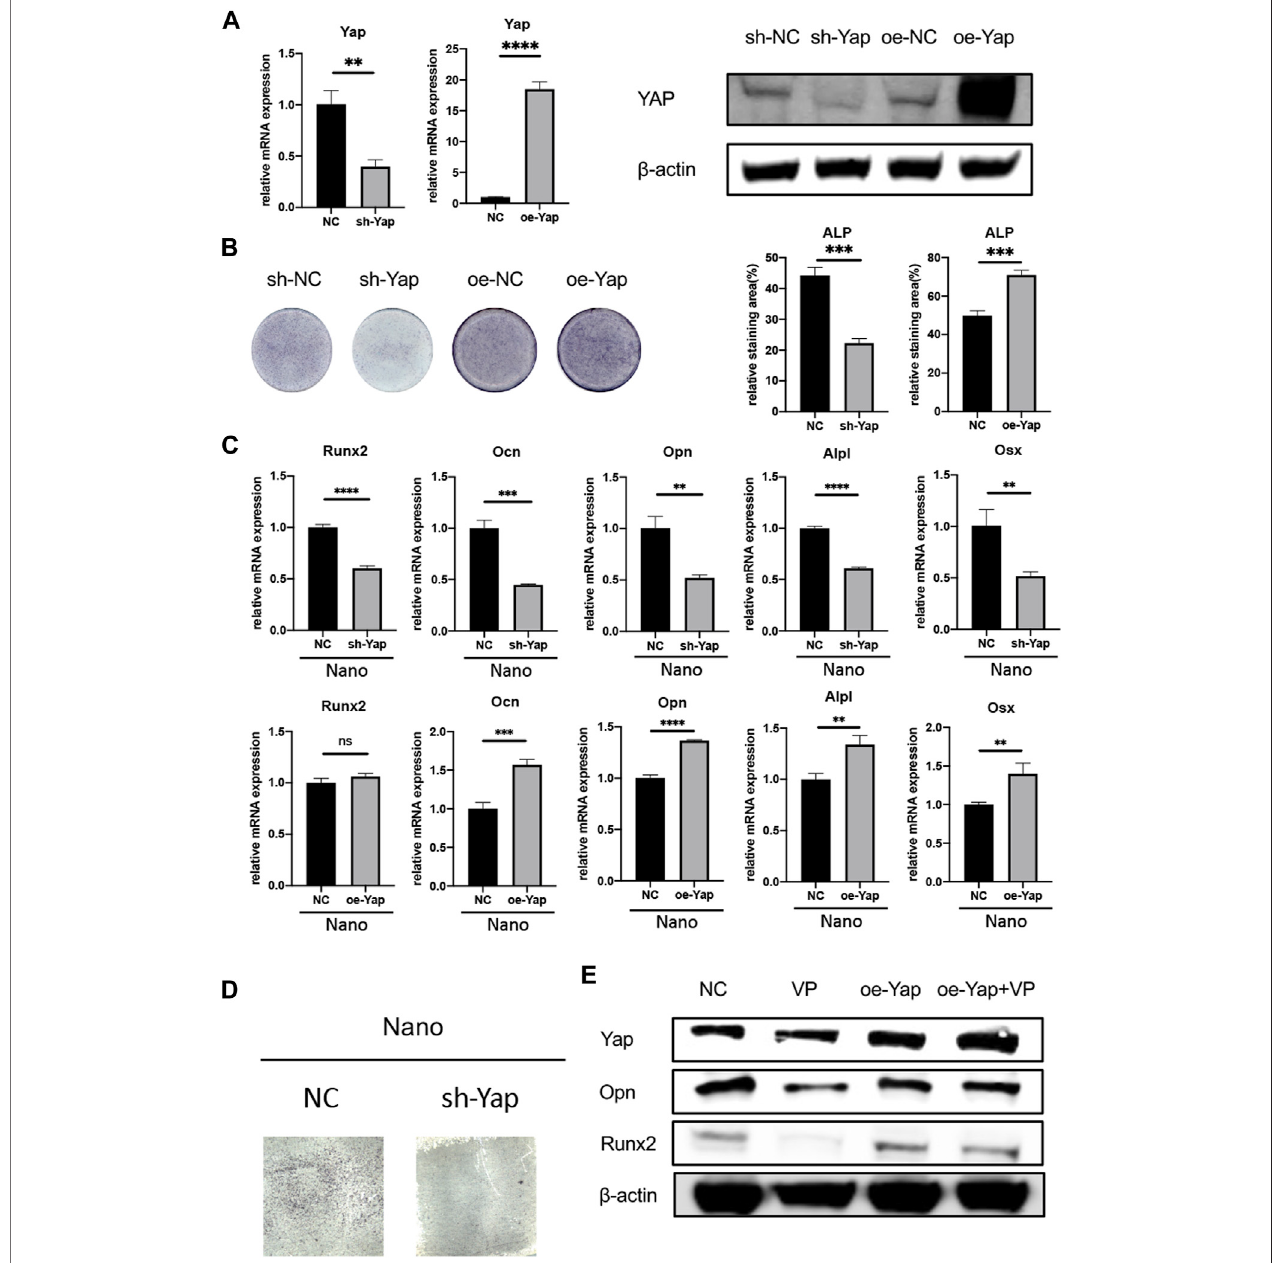
FIGURE 5 | Knockdown/overexpression of Yap regulates osteogenesis. (A) Veri fi cation of knockdown and overexpression of Yap through rt-qPCR and Western Blot.oe,overexpression. (B) ALPstainingofsh-Yapandoe-Yapandquantitativeanalysisoftherelativestainingarea. (C) Expressionofosteogenicgenesofsh-Yapand oe-Yaponnanotopography. (D) ALPstainingofsh-Yapcellsonnanotubes. (E) OverexpressionofYapcouldrescueanti-osteogeniceffectofvertepor fi n.* p < 0.05,** p < 0.01, *** p < 0.001, and **** p < 0.0001.